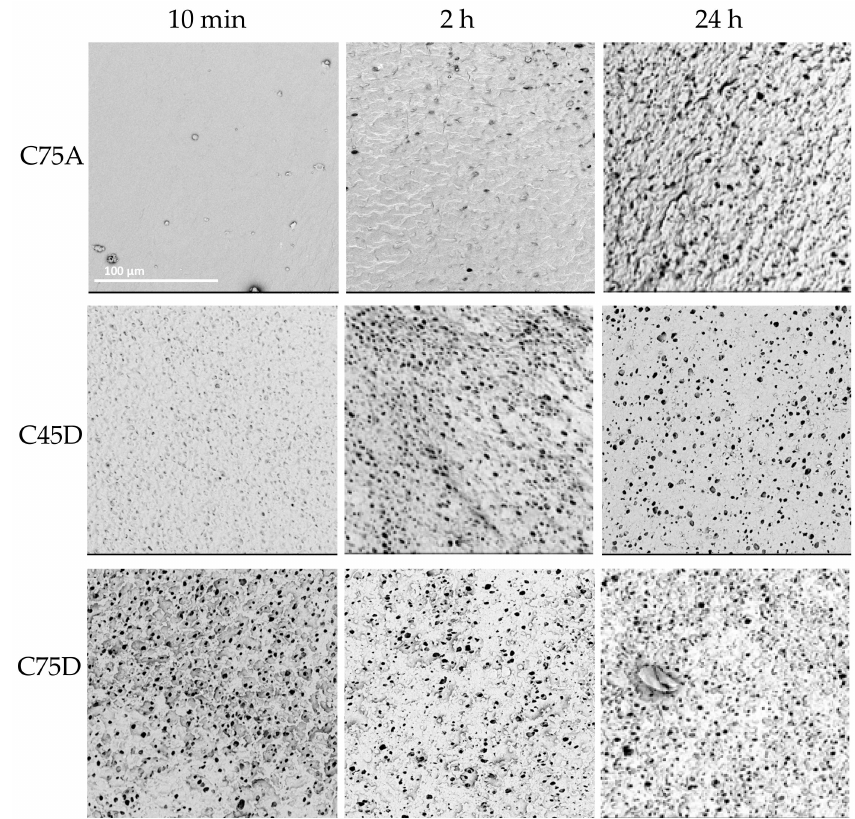
Figure 7. Morphology of internal surface of cylindrical scaffolds obtained from ChronoFlex C75D, C75A and C45D for different process times; scale bar: 100 µ